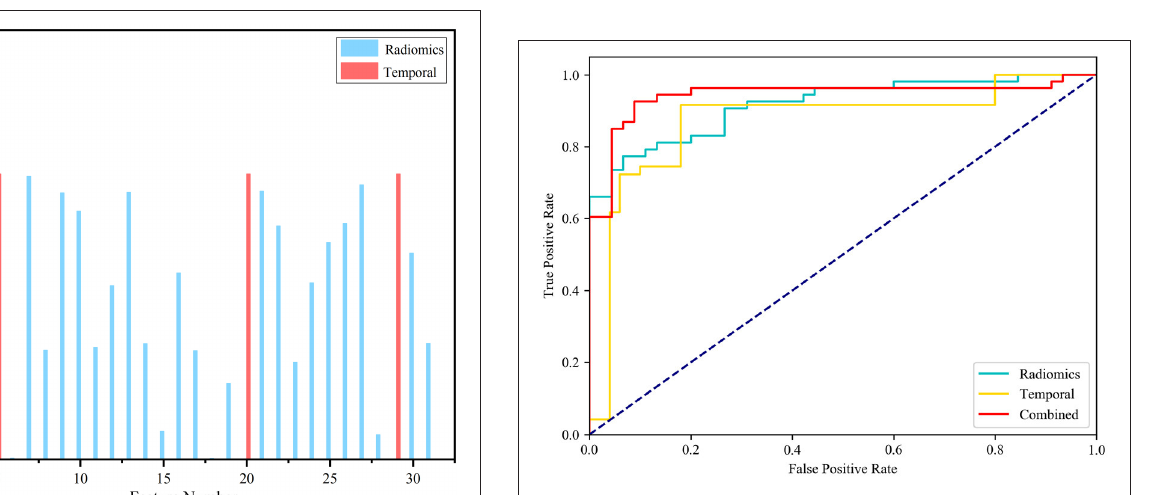
FIGURE 7 | Receiver operating characteristic (ROC) curves. Diagnostic performance of different feature group models in independent testing. While comparing the AUC curve s between radiomics, temporal and combined features, the AUC of combined features [0.942, (0.875–0.979)] was the highest one.